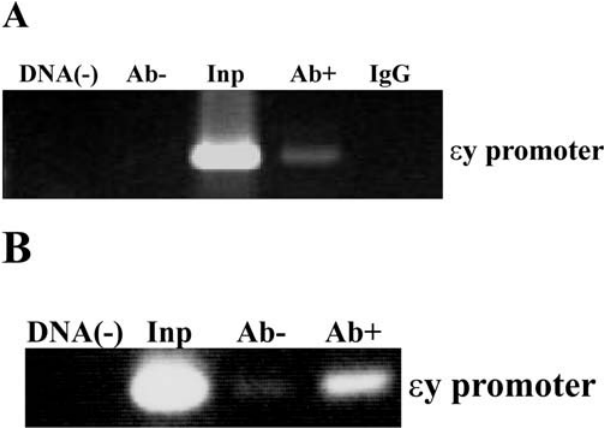
Figure 4. ChIP Assay MEL cells (A) and 15.5-dpc fetal liver cells (B) were treated as detailed in Materials and Methods. 10% of the sample was saved as total input (Inp); remaining samples were divided: plus Sox6 antibody (Ab þ ), minus Sox6 antibody (Ab (cid:1) ), as well as no DNA (DNA (cid:1) ) and normal rabbit IgG (IgG) that served as negative controls. Other controls for these experiments included PCR within the promoter of the a -globin gene and intron 24 of the p gene. Both were negative (unpublished data). PCR was carried out using primer pairs flanking the Sox/Sox6 binding sites (see Material and Methods) of the e y proximal promoter. For all reactions, we used 2 l l of immuno-precipitated DNA and 2 l l of 1/100 total input. Semiquantita- tive PCR was done within the exponential range. Multiple independent experiments were